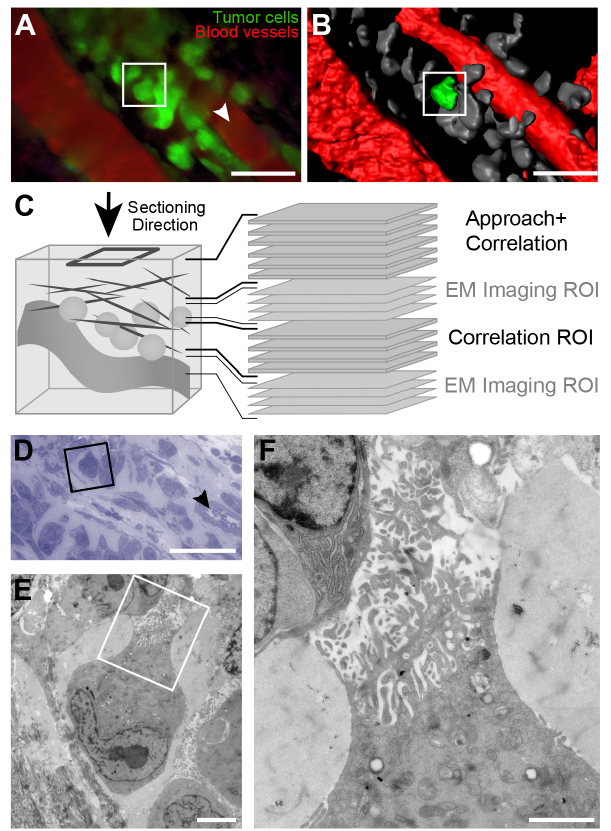
Figure 2. Correlation based on Sequential LM and EM imaging to Target a Single Tumor Cell. A. 3D view of a 2PEM z-stack of mouse ear skin tissue, 7 days post-injection with GFP-expressing tumor cells (green). Vessels are stained with Evans Blue (red). The arrowhead indicates the part of the blood vessel that is also visible in the thick section shown in panel D. The image is obtained using the 3D Viewer plugin in Fiji. Scale bar: 50 m m. See Movie S2. B. 3D model of the imaged volume. The cell of interest, boxed in panel A and B, is segmented in green, the other cells are segmented in grey. The vessels are shown in red. Scale bar: 50 m m. C. Cartoon of the sectioning procedure. The resin embedded sample is sectioned from the direction indicated with the arrow. To approach the ROI, 180 thick sections (500 nm) were obtained from the sample (’Approach and Correlation’). Next, 10 consecutive series of 10 thin (60 nm) and two thick (500 nm) sections were obtained from the ROI. Thick sections were used for correlation and the thin sections were imaged with EM. D. The cell of interest (box) was identified in a thick toluidine blue stained section of the ROI. The arrowhead points to a cross-section of the vessel depicted in A with a white arrowhead. Scale bar: 50 m m. E: Low magnification EM image of the cell boxed in panel D. The cell appears highly polarized and contains protrusive structures, showed at higher magnification in panel F. Scale bar in E: 5 m m, in F: 2 m m. See Movie